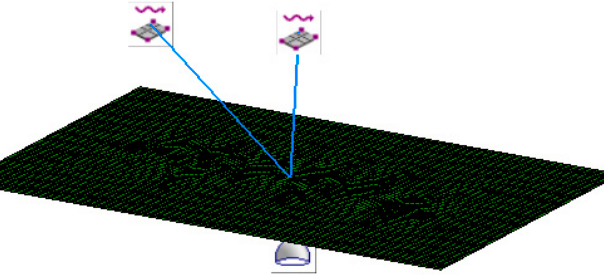
Figure 17. Modes of the panel: ( a ) 153.2 Hz; ( b ) 398.49 Hz.